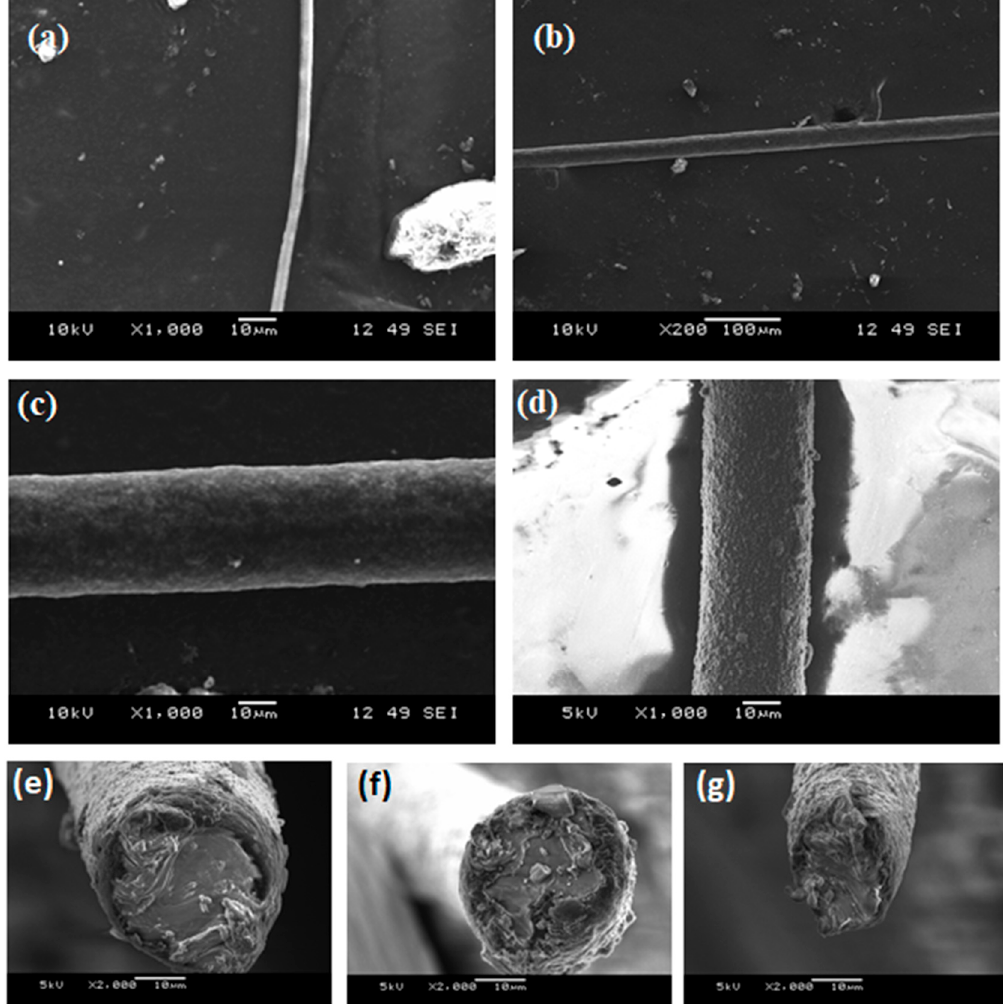
Figure 4. SEM images of ( a ) solution electrospun neat A85 fiber; extruded neat A85 fiber, ( b ) low magnification, and ( c ) high magnification, ( d ) 2-layer fiber with A85 core with carbon-black ( e – g ) examples of cross section that shows large deformation due to compression from the razor blade.